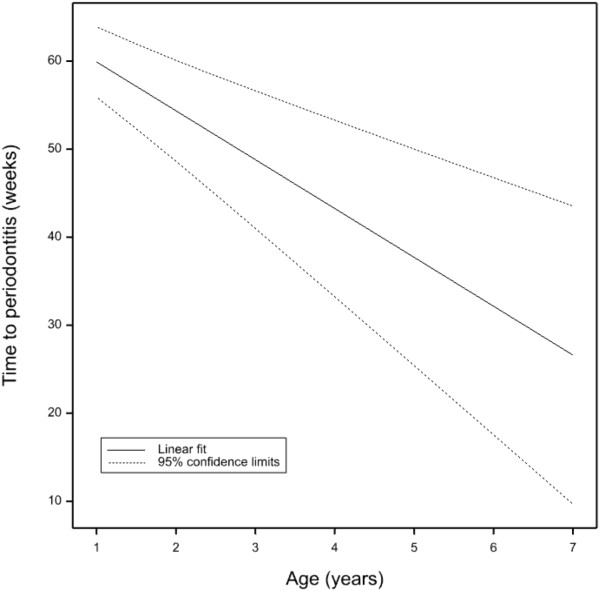
Estimated linear fit of age against time to periodontitis with 95% confidence limits.